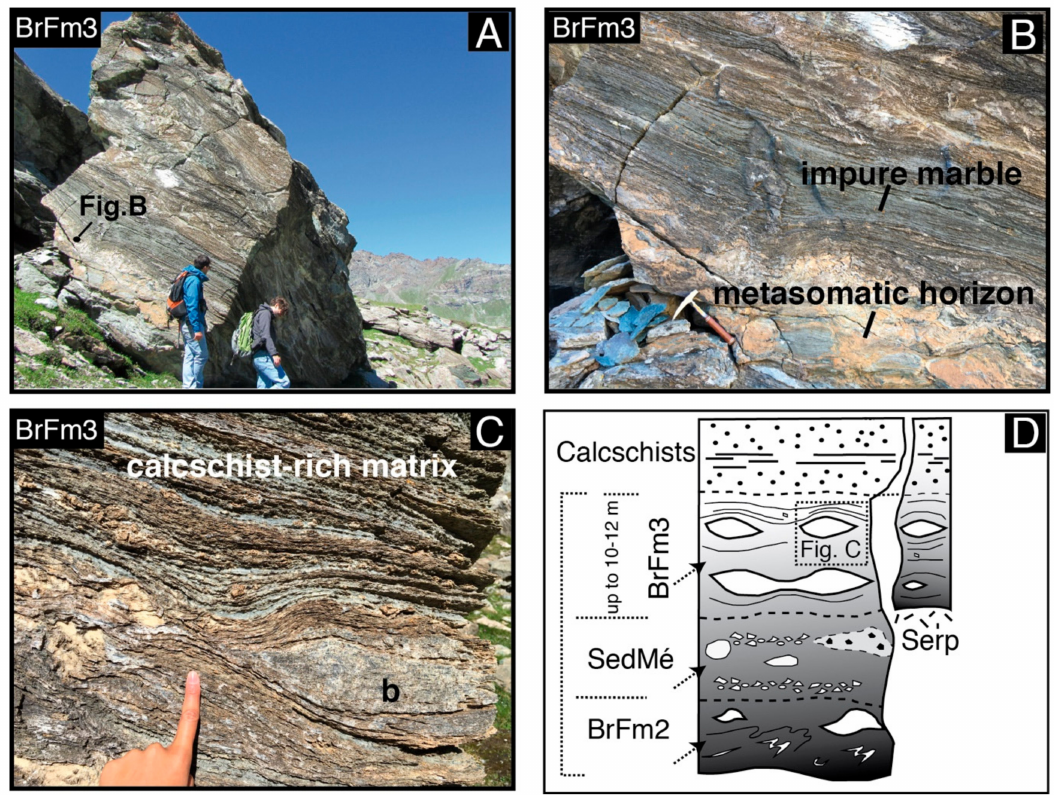
Figure 6. Outcrop views of Broken formation 3 (BrFm3) in the CCU. ( A ) General outcrop view of the BrFm3 exposed to the N and NE of Lake Miserin. ( B ) Contact between the impure marble and calcschist-rich matrix of the BrFm3 and the underlying metasomatic horizon. ( C ) Close-up of the boudinaged ultramafic metasandstone horizons (b) consisting of medium- to fine-grained ultramafic metasandstone (Srp ± Amp ± Chl ± Ep). ( D ) Conceptual cartoon illustrating the internal fabric of the BrFm3 unit in relation to the surrouding